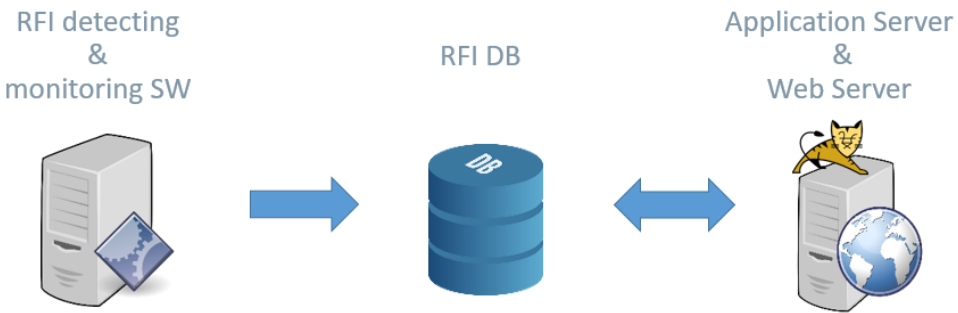
Figure 6. ERMIT high-level architecture.